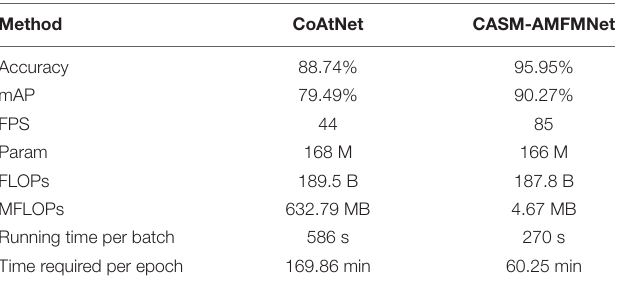
TABLE 5 | Performance comparison of CoAtNet and coordinated attention shuffle mechanism-asymmetric multi-scale fusion module net (CASM-AMFMNet).